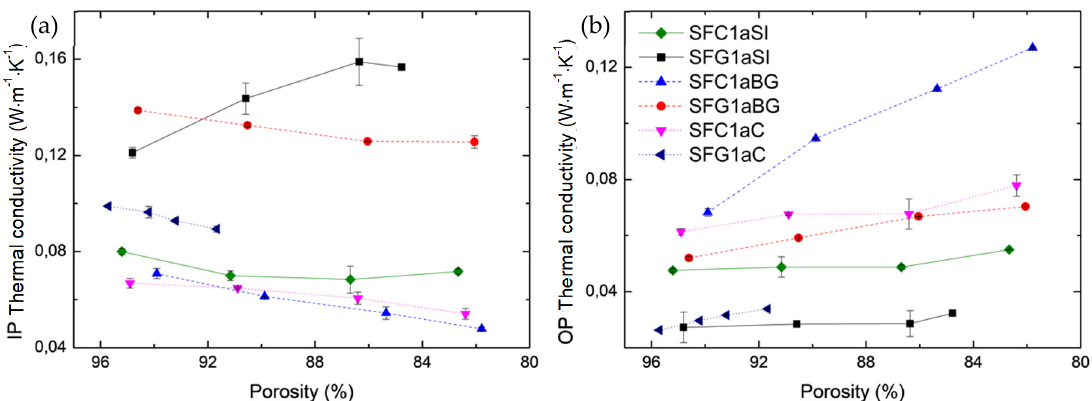
Figure 13. Thermal conductivity of Rayon-derived soft CFs as a function of porosity, at the initial material porosity and after each decrease (under load), in both directions: ( a ) in-plane and ( b ) out-of-plane. The symbols in ( b ) have the same meaning as in ( a ). The lines are just guides for the eye.